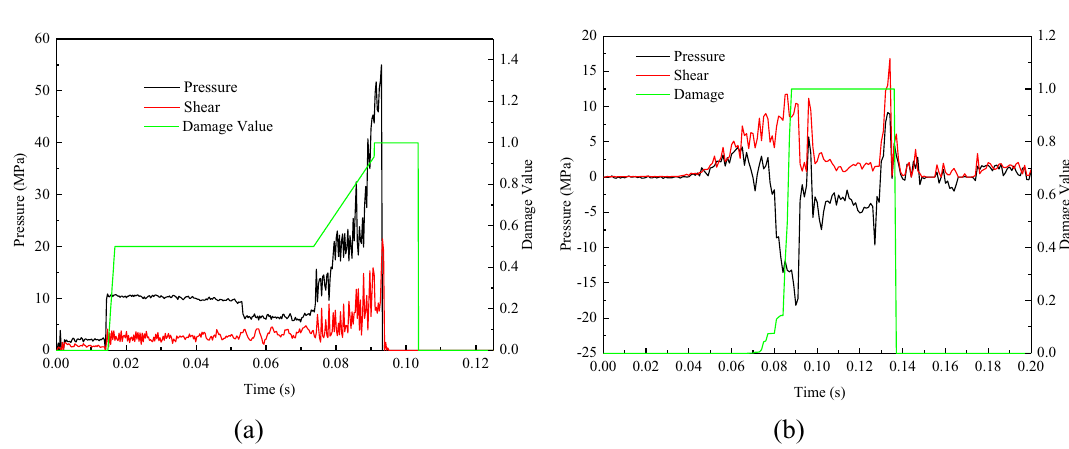
Figure 7. Pressure and corresponding damage versus time in different